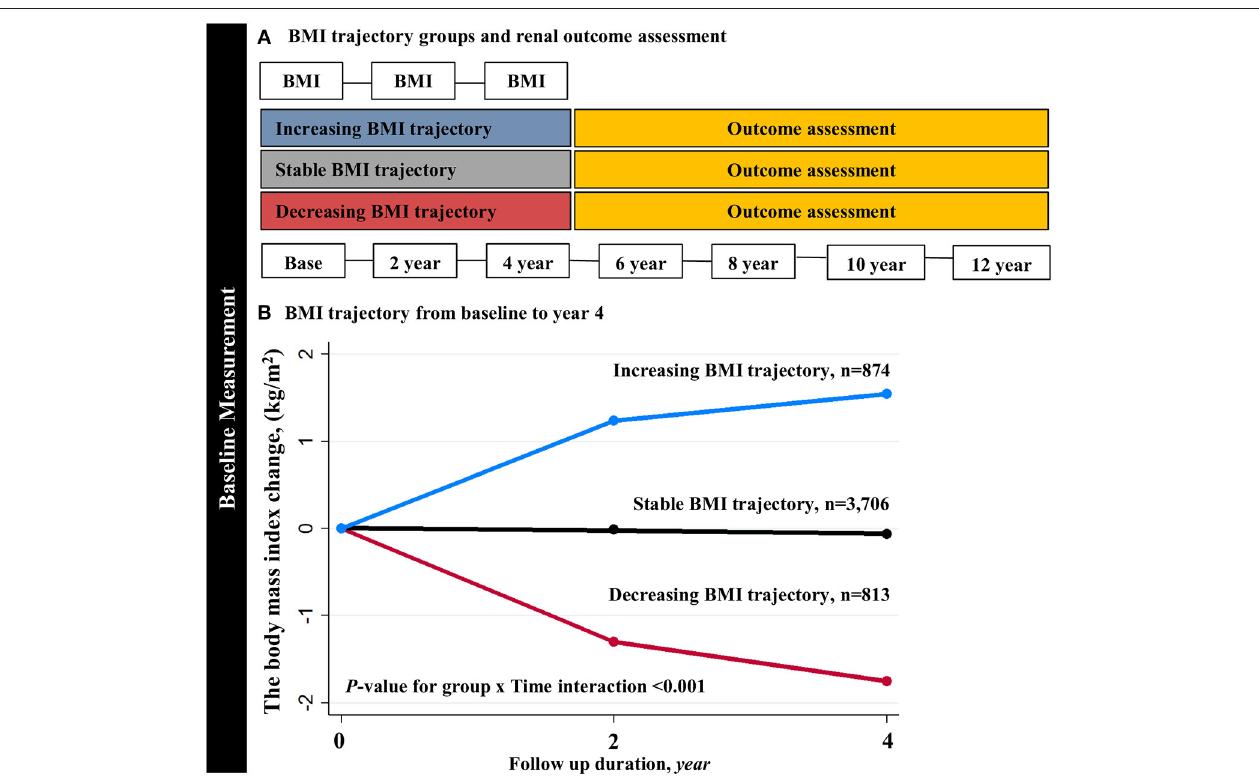
FIGURE 1 | Trajectory modeling identified three distinct BMI trajectory groups. (A) The primary analysis derived BMI trajectory groups using the first 4-year BMI measurements. (B) The slopes of BMI trajectories were significantly different across the three groups ( P- value for group × Time interaction < 0.001). BMI, body mass